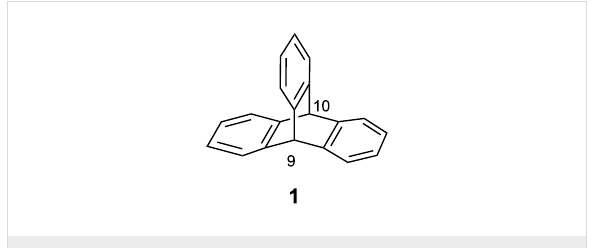
Figure 1: Structure of triptycene ( 1